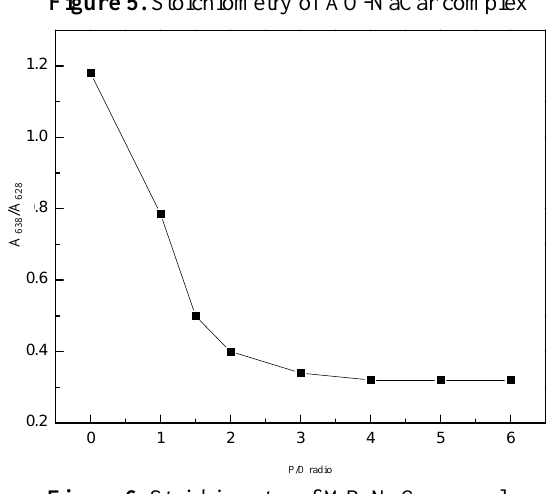
Figure 5. Stoichiometry of AO-NaCar complex